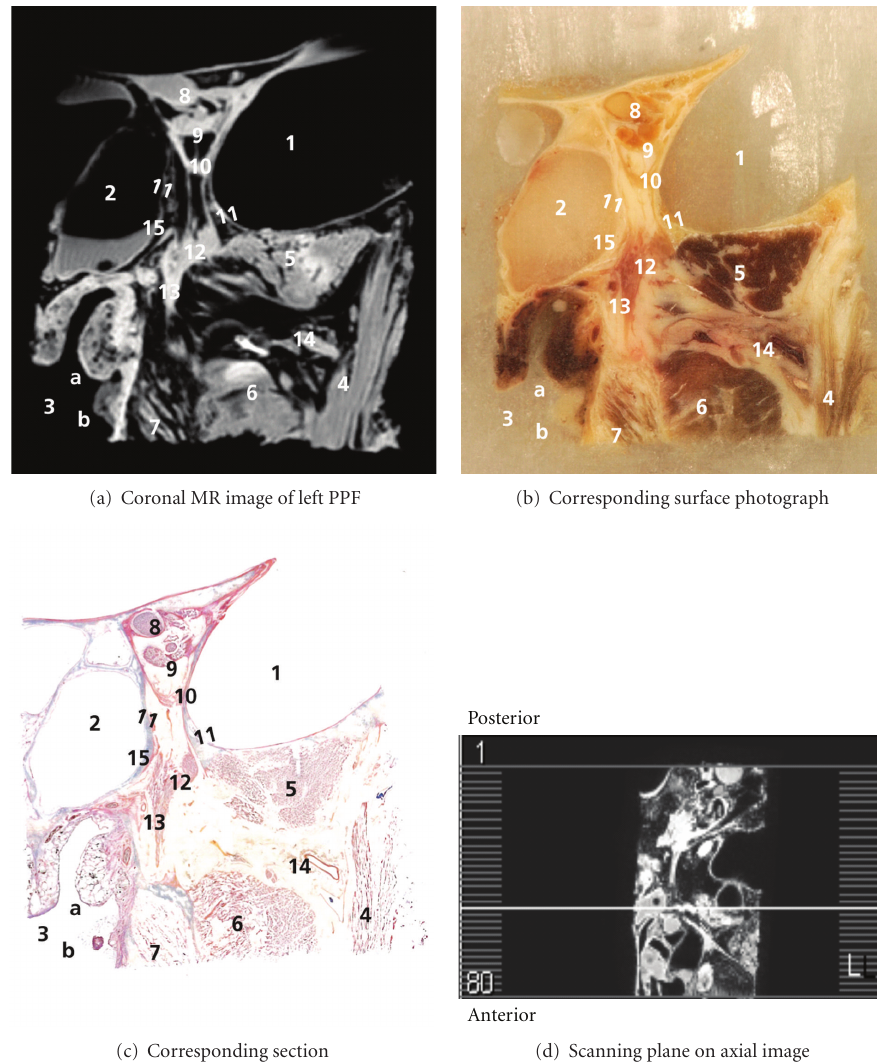
Figure 3: 1–11: see Figure 2. 12: PPG, 13: greater palatine nerve, 14: maxillary artery, and 15: pharyngeal nerve.